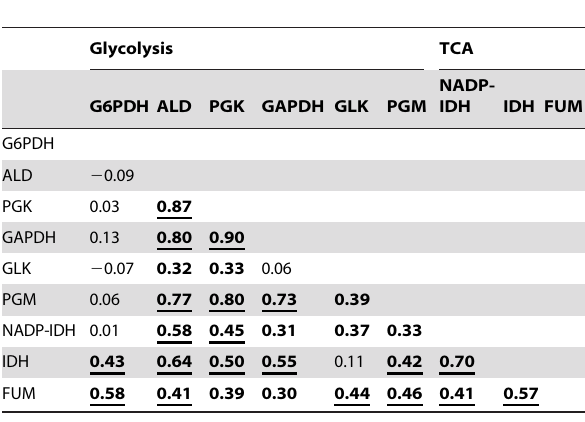
Correlations were calculated from measurements of 40 samples representing 8 lines in 5 replications each. Bolded values: P , 0.05. Underlined values: P ,